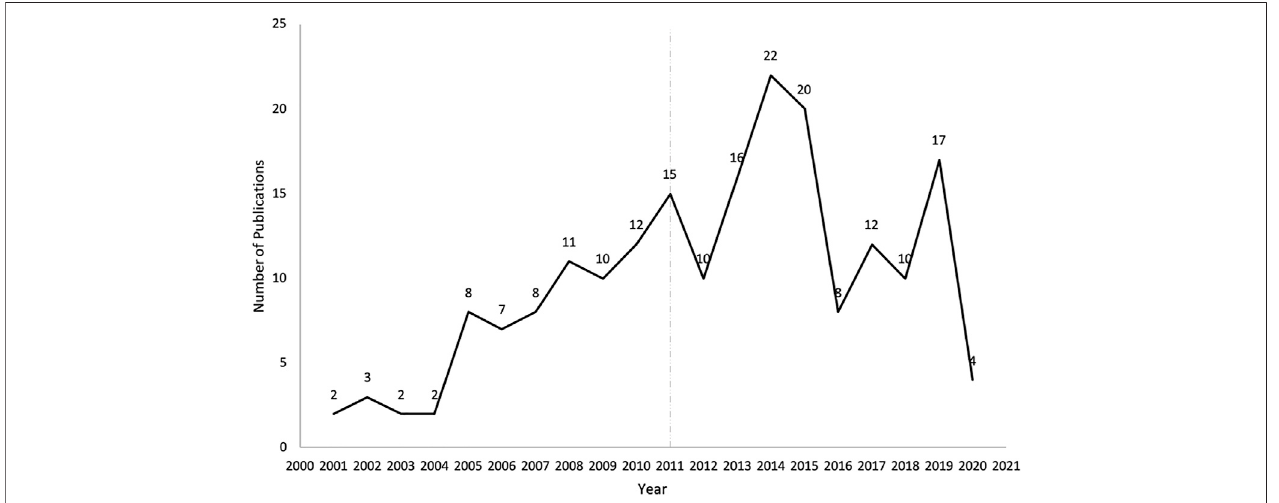
FIGURE 2 | The number of publications of pharmacoeconomics evaluation of herbal medicine by years. The vertical line for 2011 represents the publication of China ’ s PE guidelines.